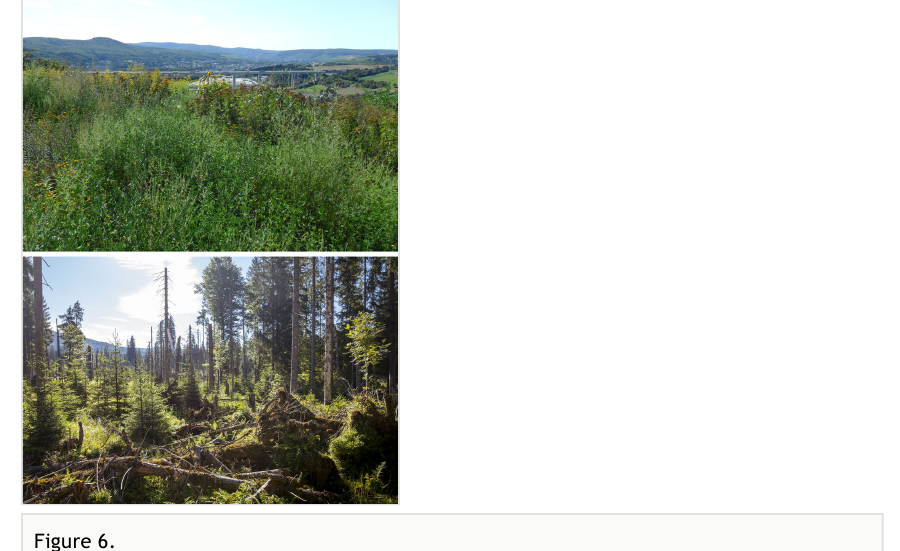
Picture of the direct vicinity of the two Malaise trap locations. Top: GMTPZ adjacent to the Middle River Rhine Valley, view towards the River Ahr valley (by GBOL Team); bottom: GMTPE in the Nationalpark Bayerischer Wald (by Bernhard